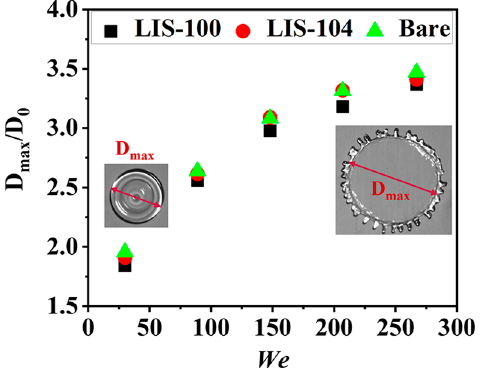
Figure 6. Variation in maximum spreading factor (D max /D 0 ) with We number for bare, LIS-100 and LIS-104.